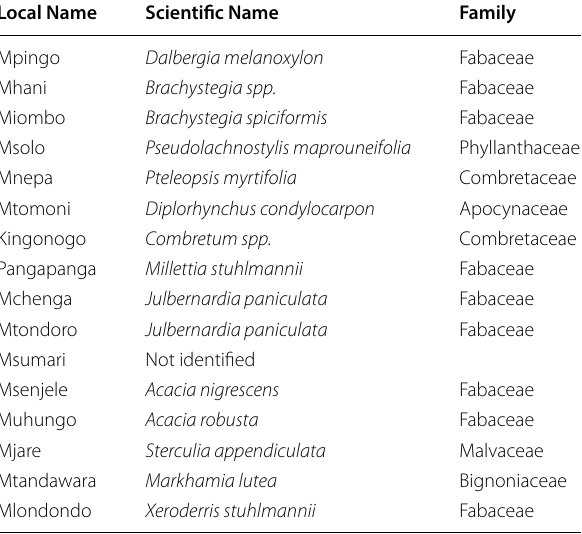
Table 1 Local and scientific names of trees in the